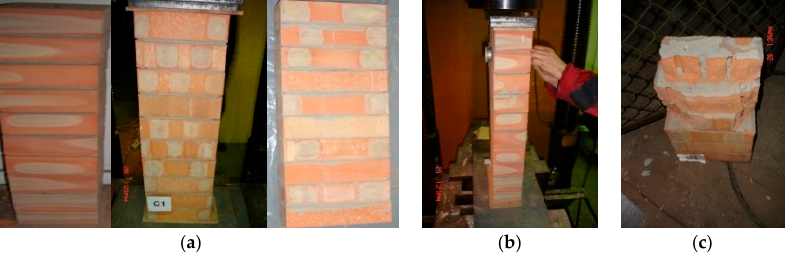
Figure 3. Ceramic brick wall segment without reinforcement, cross-section 12 × 25 cm: ( a ) from preparation; ( b ) under load; ( c ) destruction.